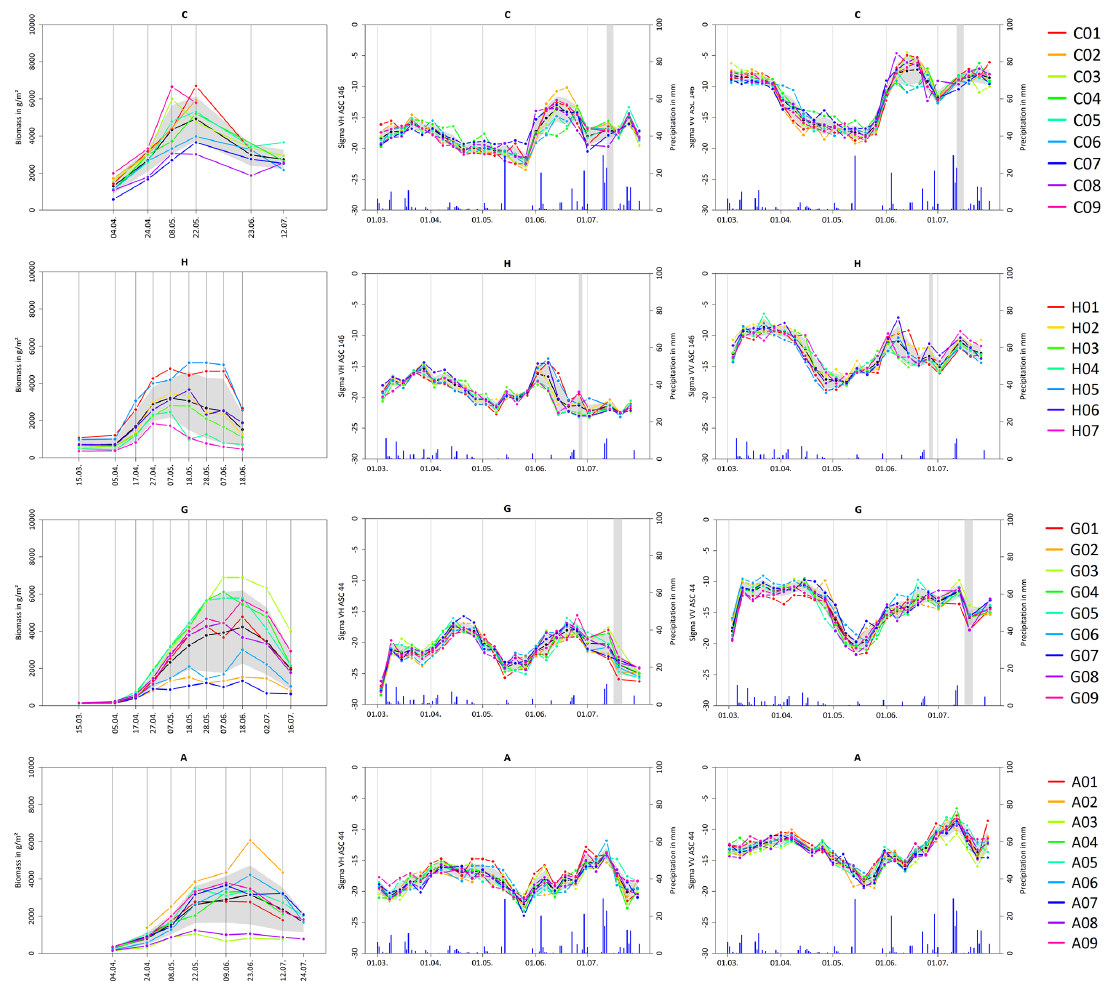
Figure 13. Temporal profiles of single fields: wet biomass ( left ), VH backscatter ( center ) and VV backscatter ( right ). The black line framed by a gray polygon represents the mean value of the field +/ − one standard deviation. Gray bars indicate harvest periods, blue bars represent